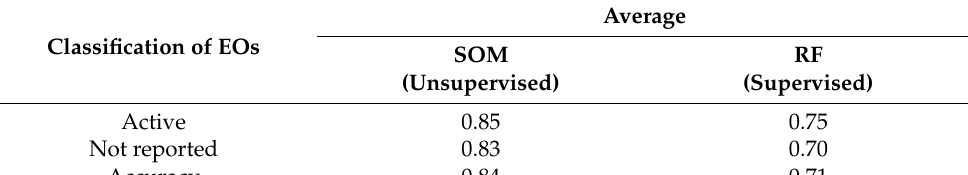
Table 3. Summary of test averages corresponding to 5-fold cross-validation using the different machine learning algorithms, self-organizing maps (SOM) and random forest (RF).